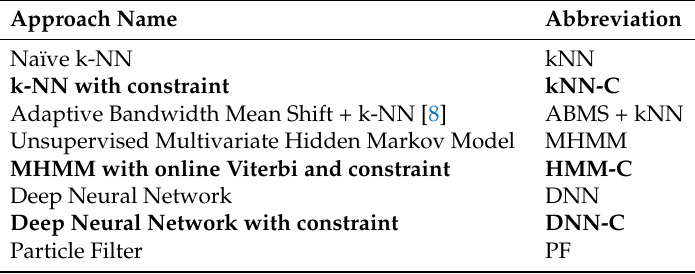
Table 2. Studied approaches for the